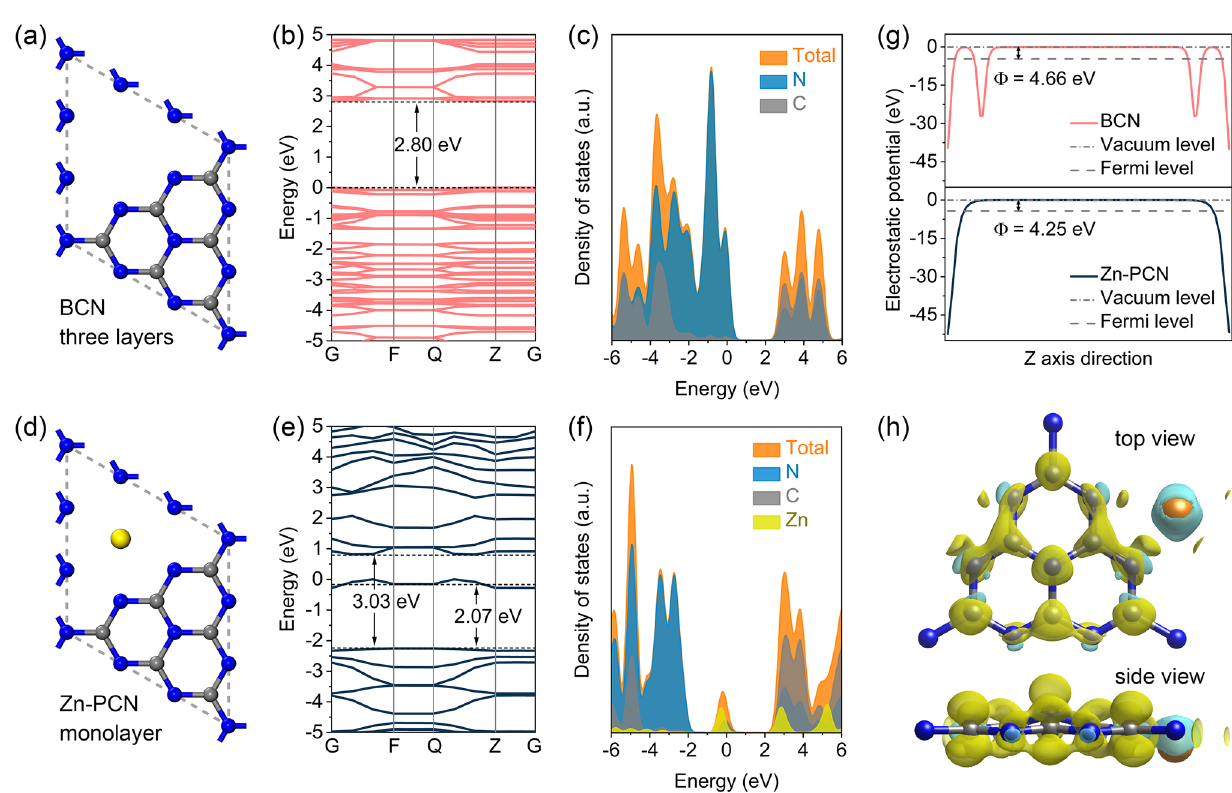
Fig. 3 Structure models of a BCN and d Zn‑PCN. b , e Calculated band structures and c , f corresponding DOS of BCN and Zn‑PCN, respec‑ tively. g Electrostatic potentials of BCN (002) plane and Zn‑PCN (002) plane. h Differential charge density map of Zn‑PCN. The iso‑surface value is 0.012 e Å −3 . The yellow and cyan regions represent net electron accumulation and depletion, respectively. The gray, blue and yellow spheres represent the C, N and Zn atoms,